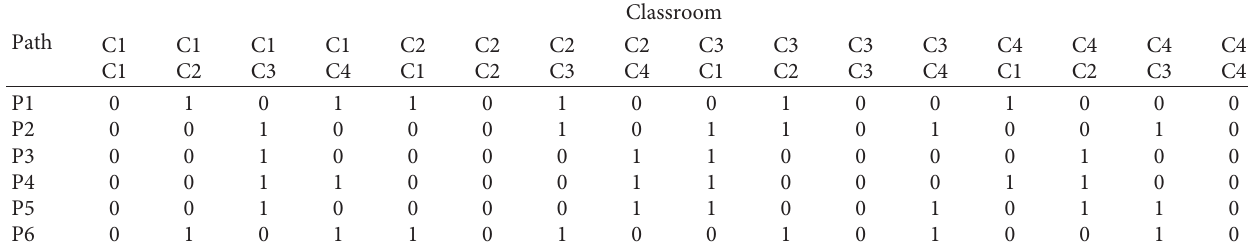
Table 8: All paths that connect classrooms.